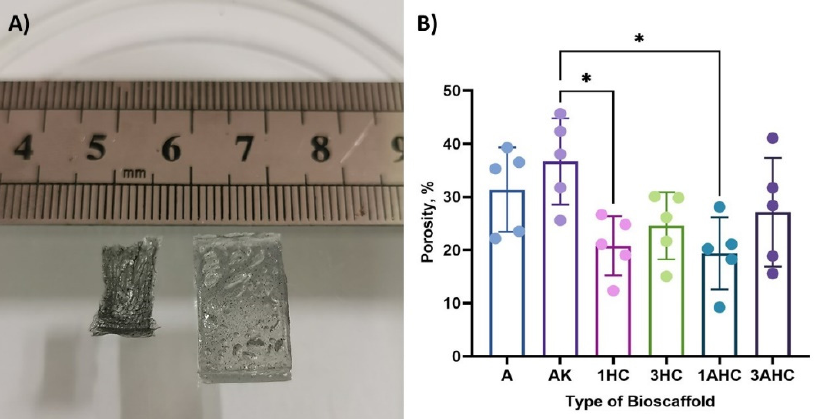
Figure 5. ( A ) Image of dried and rehydrated CHAK. ( B ) The porosity of the fabricated bioscaffolds. The dots on the graph represent individual value of each sample in the group. The statistical signif- icance was considered at a probability of p < 0.05 (* p = ≤